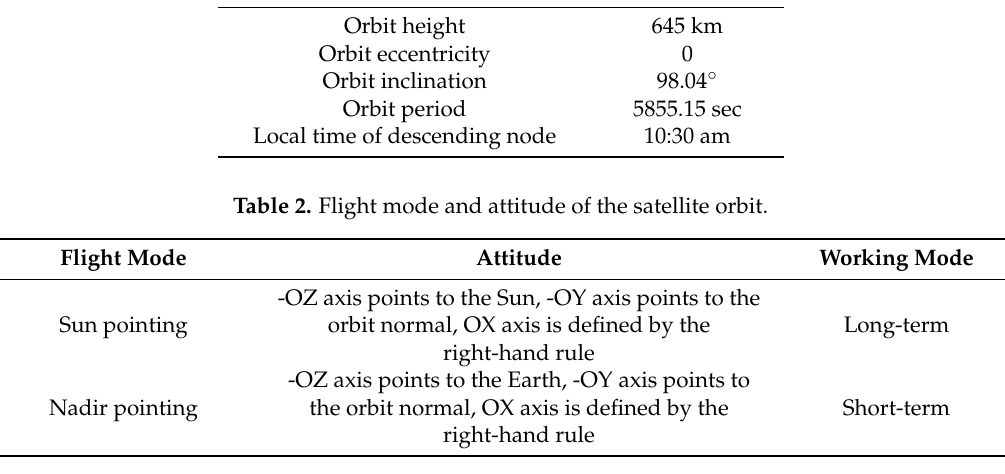
Table 1. Orbit parameters of satellite in general.